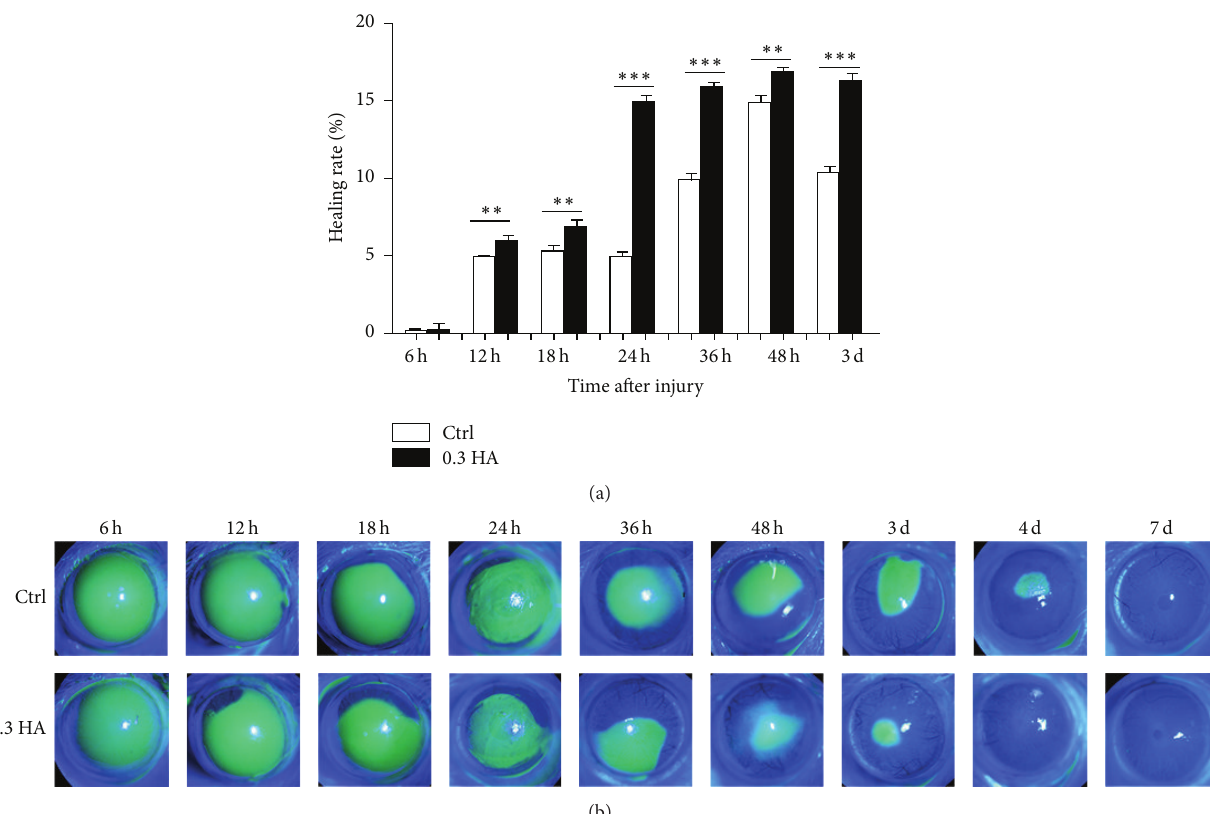
Figure 3: Hyaluronate accelerated corneal epithelial wound healing in the heptanol-burned model. SD rat corneal epithelial cells were removed by burning with heptanol. The healing rates (a) and fluorescein-stained corneal images (b) revealed the healing processes of the corneal lesions in the rats at 6 h, 12h, 18 h, 24 h, 36 h, 48 h, 3 d, 4 d, and 7 d after injury in the control and 0.3 HA groups. Magnification: × 16, ∗ 𝑝 < 0.05 ; ∗∗ 𝑝 < 0.01 ; ∗∗∗ 𝑝 < 0.001 . The data are the mean ± SEM and represent individual experiments, each including 5